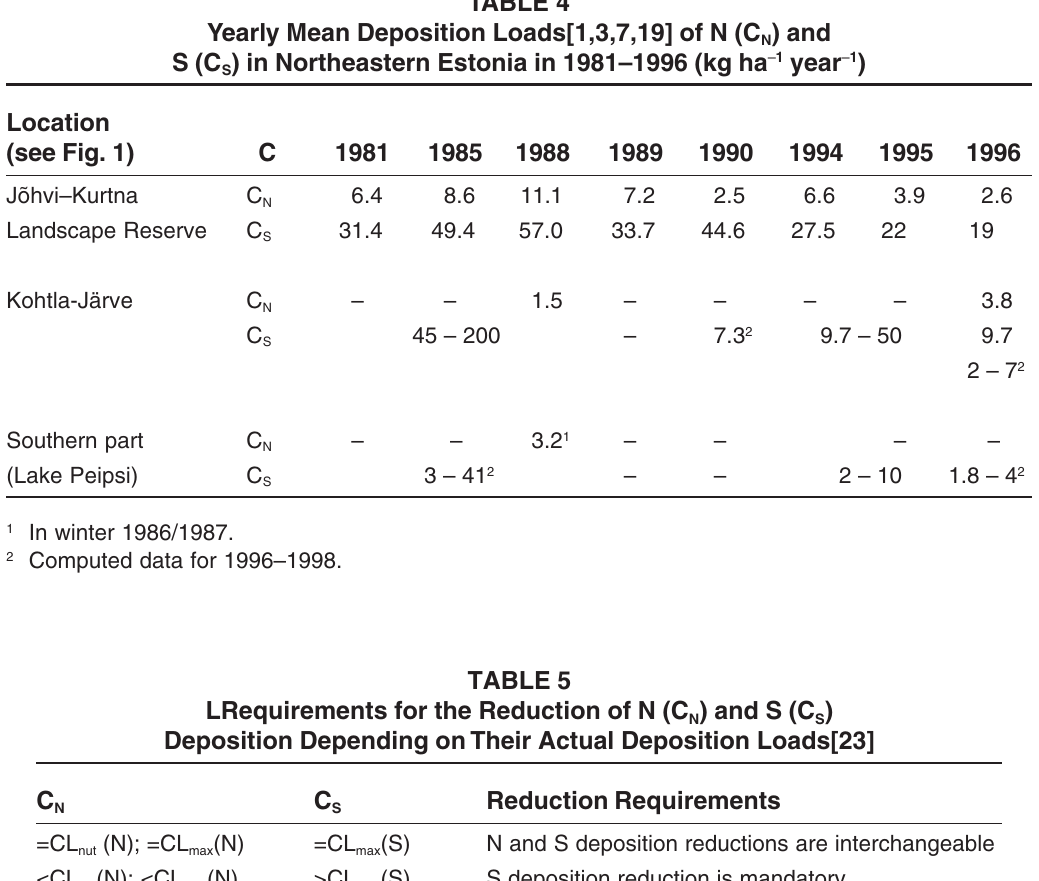
Yearly Mean Deposition Loads[1,3,7,19] of N (C